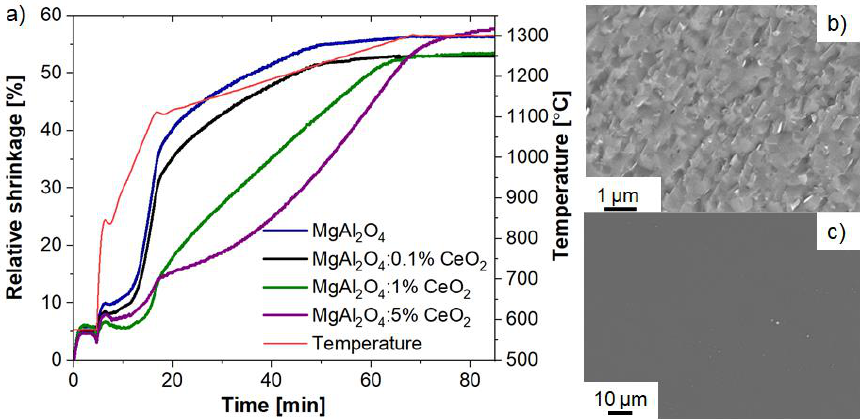
Figure 2. Linear shrinkage dynamics of undoped and Ce-doped MgAl 2 O 4 ceramics during the SPS consolidating process ( a ). SEM images of fabricated ceramics analyzed from fracture ( b ) and surface ( c ) side, respectively.